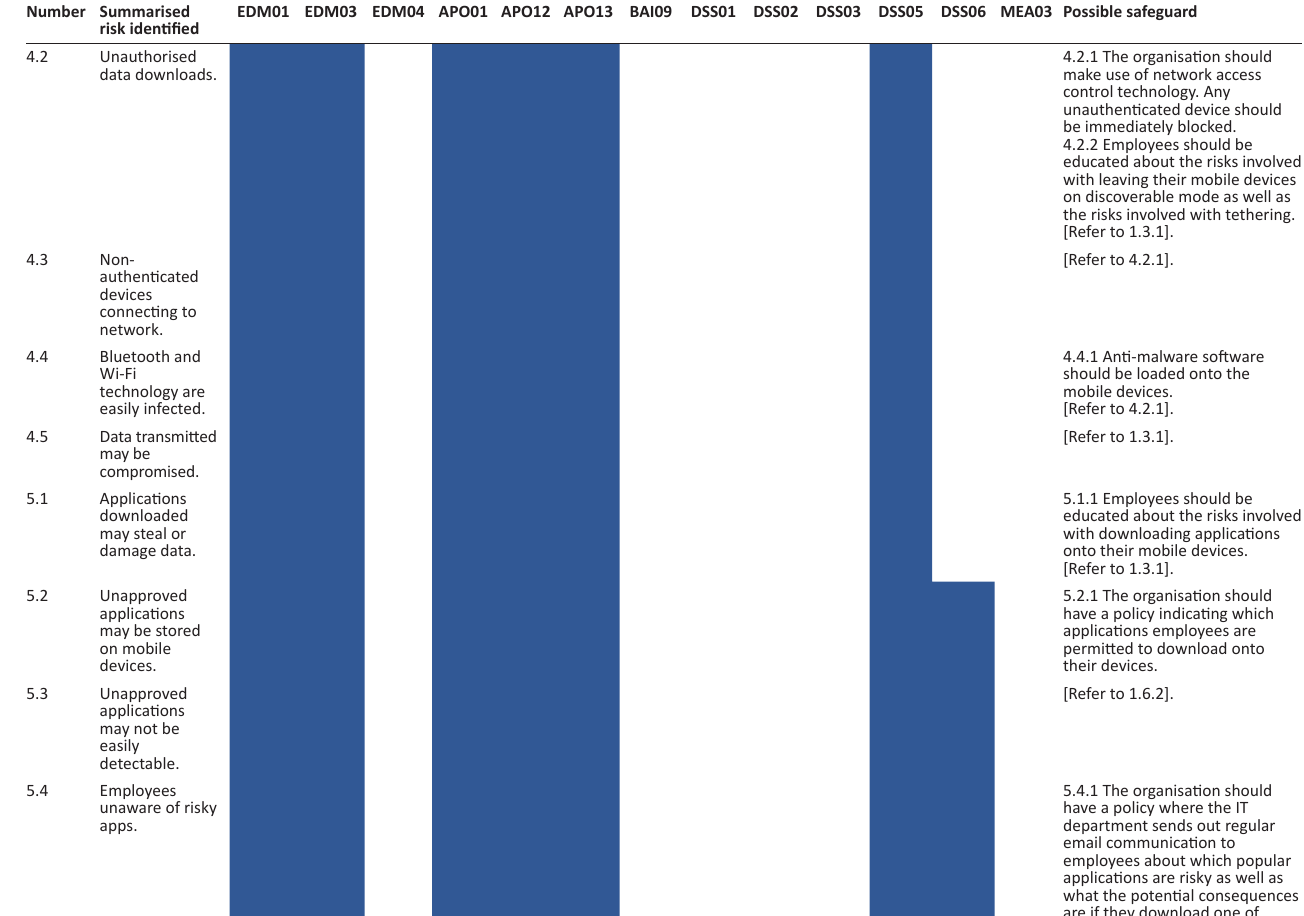
FIGURE 1 (Continues...): Mapping risks to possible